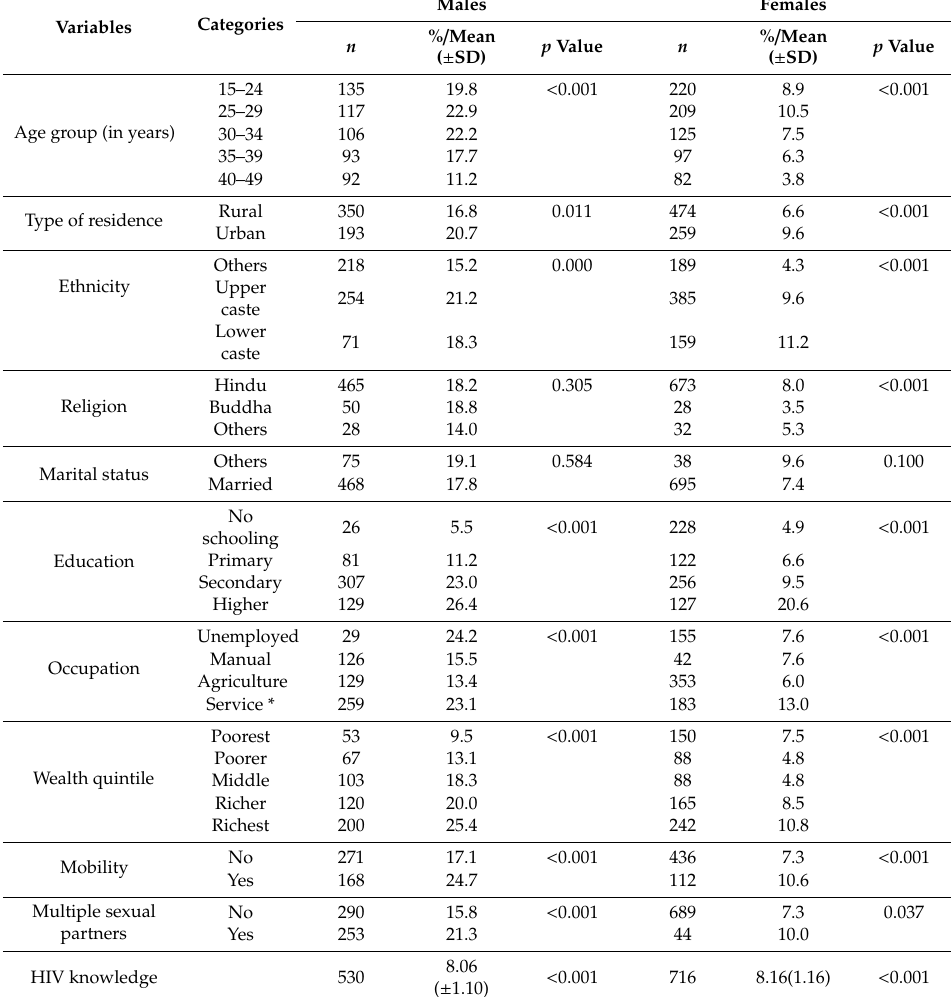
Table 3. HIV Testing by Sociodemographic and Behavioral